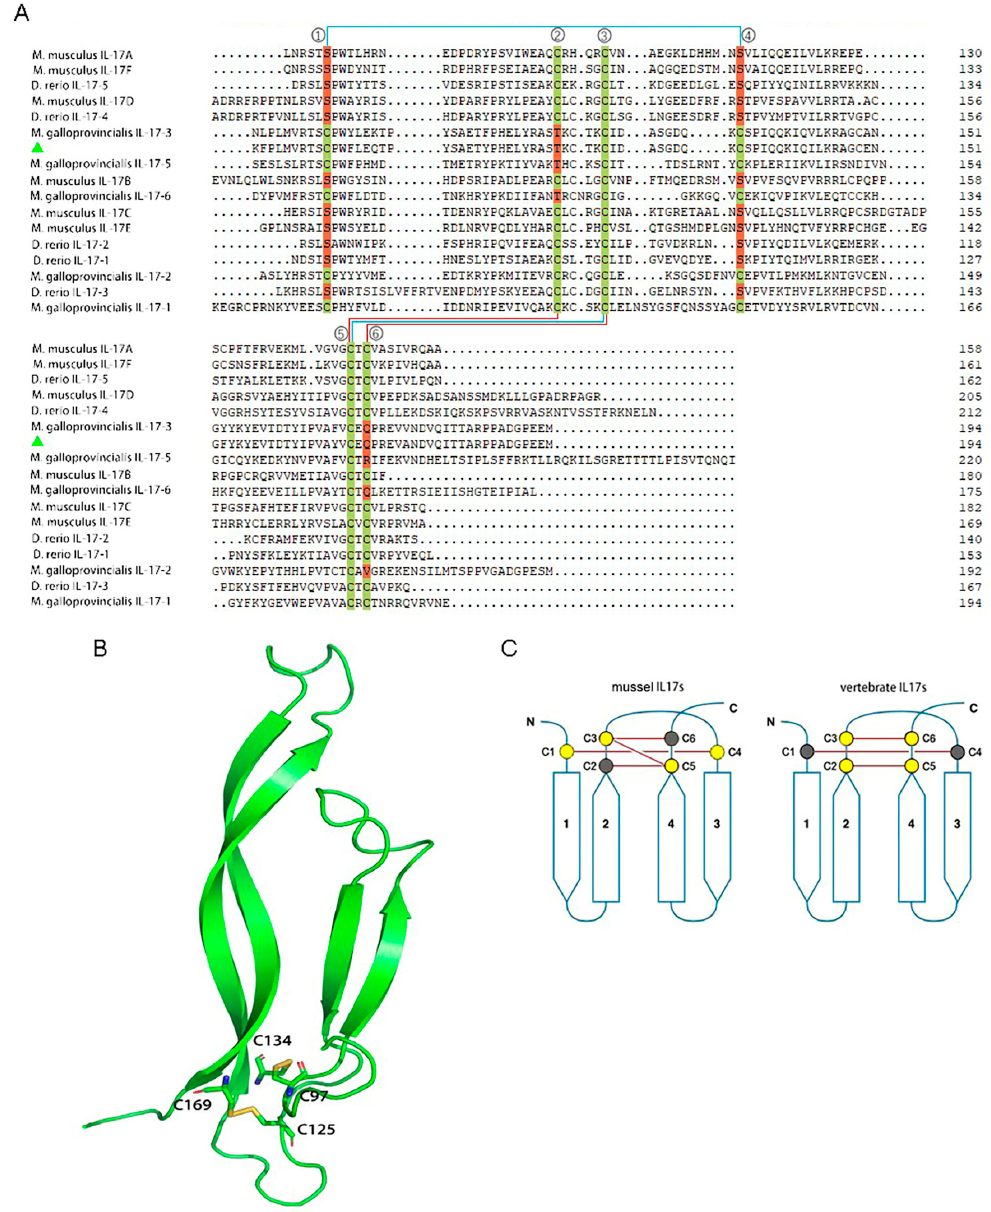
Figure 2. Multiple alignment of Mc IL-17-3 with other IL-17 family members. ( A ) The amino acid sequence of Mc IL-17-3 was aligned with that of other IL-17s retrieved from mussels and vertebrates, including mice and zebrafish. These cysteines, which form a canonical knot, were marked with green, with replaced amino acid residues marked with red. The cysteines knot is indicated by color lines, and blue meaning their presence in molluscs and red meaning their presence in vertebrates. Note: Only the second half of the sequence alignment is preserved for visualization. ( B ) The tertiary structure of Mc IL-17-3 protein was predicted using the Swiss model and pyMol software. These cysteines, which form a canonical knot, were marked. ( C ) A cartoon representation of the canonical cysteine-knot fold. Cysteine residues were indicated by filled circles; those present in IL-17 proteins were yellow, whereas the two missed were gray. (For interpretation of the references to color in this figure legend, the reader is referred to the Web version of this article.)